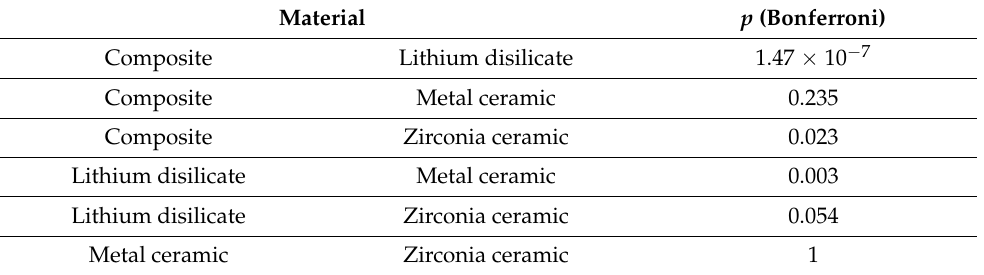
Table 2. Bonferroni test—Materials.